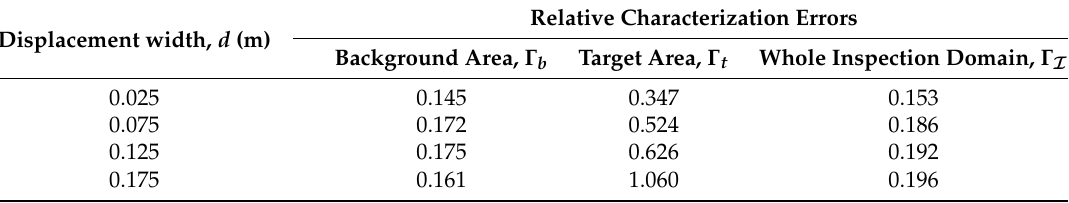
Table 5. Relative Errors on the Dielectric Characterization Versus the Sensor Displacement Width.